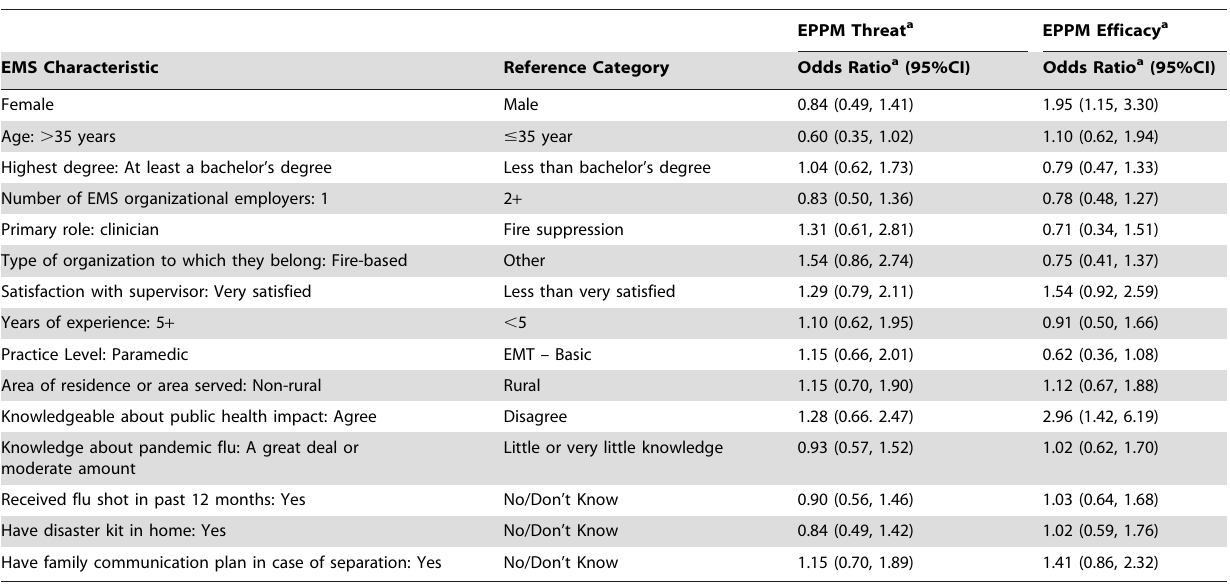
Table 4. Weighted multivariate logistic regression analyses to evaluate the associations between the Extended Parallel Process Model (EPPM) threat and efficacy dimensions and EMS characteristics regarding a pandemic influenza emergency (adjusted for all characteristics).